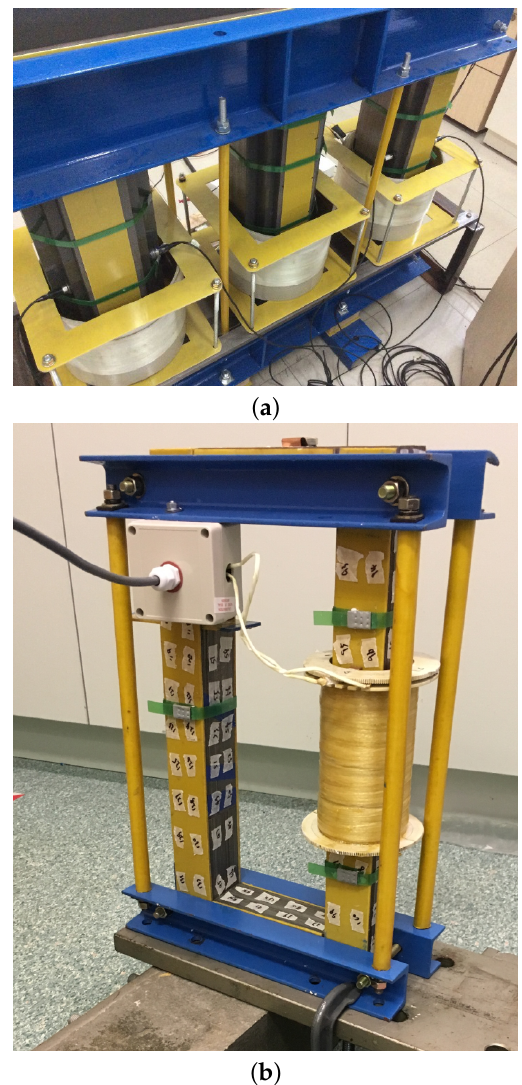
Figure 2. The configurations of ( a ) the three-phase and ( b ) the single-phase transformer